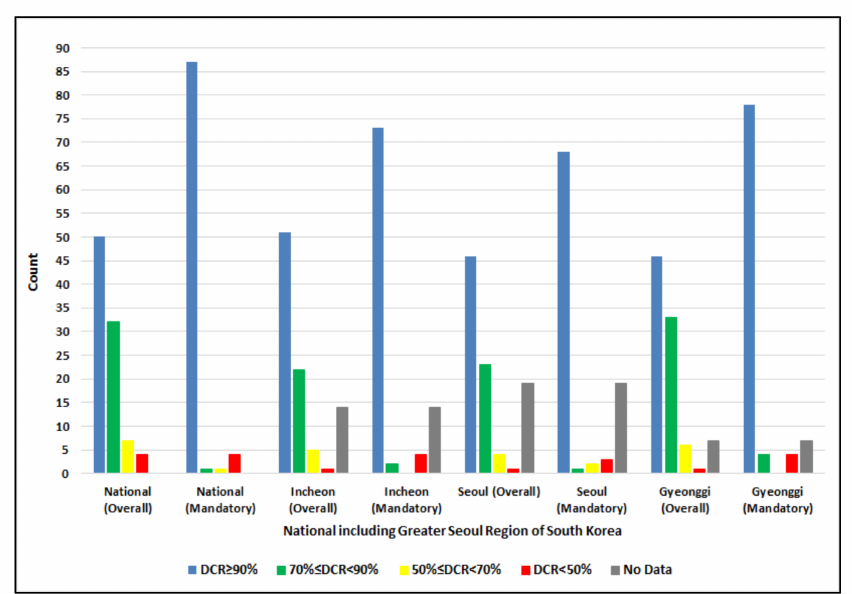
Figure 9. Categorization of the National and Greater Seoul region data files for different values of DCR